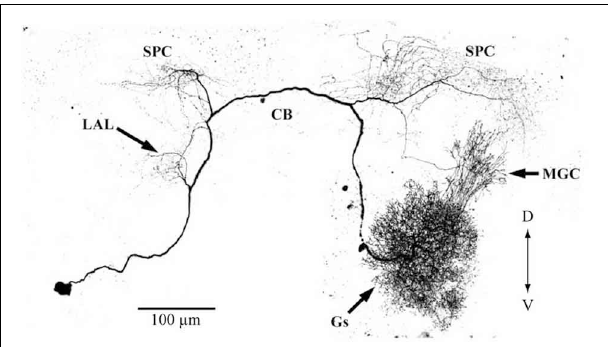
FIGURE 9 | Morphologies of putative serotonin feedback neurons. The neuron has its soma in the posterior portion of the lateral cell cluster of one antennal lobe. The primary neurite projects through the ipsilateral antennal lobe, where it has a small number of fine branches in the posterior coarse neuropil. Branches are present in the ipsilateral lateral accessory lobe, and in both the ipsi- and contralateral parts of the protocerebrum, including the calyces of both mushroom bodies and the central body. The neuron shows immunoreactivity with anti-5HT antibody. CB, central body; D, dorsal; Gs, ordinary glomeruli; MGC, macroglomerular complex; LAL, lateral accessory lobe; SPC, superior protocerebrum; V, ventral. (modified from Hill et al.,